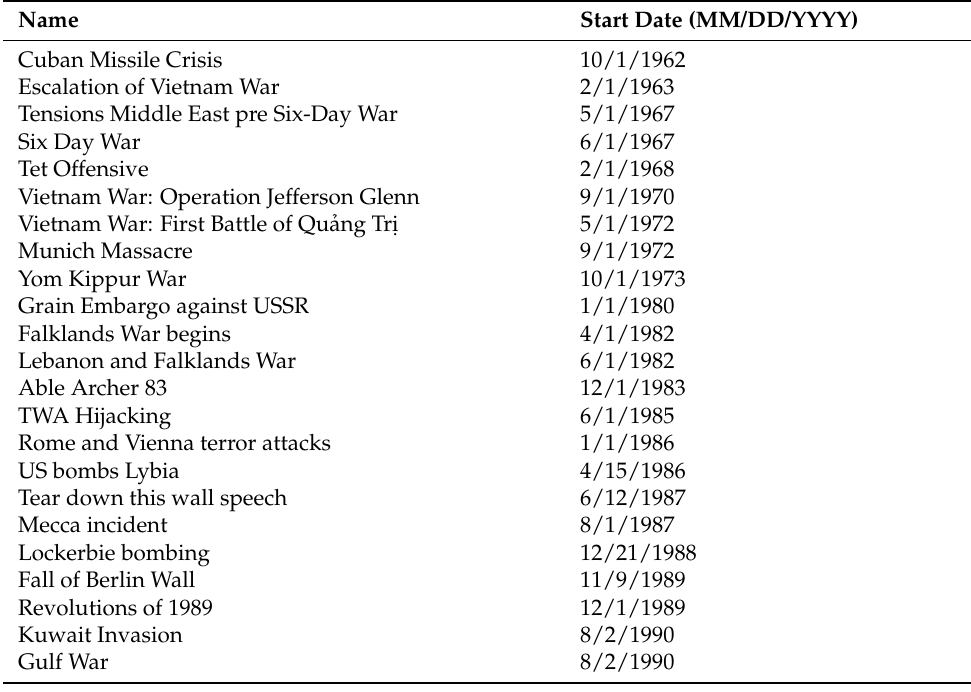
Table A2. List of geopolitical events